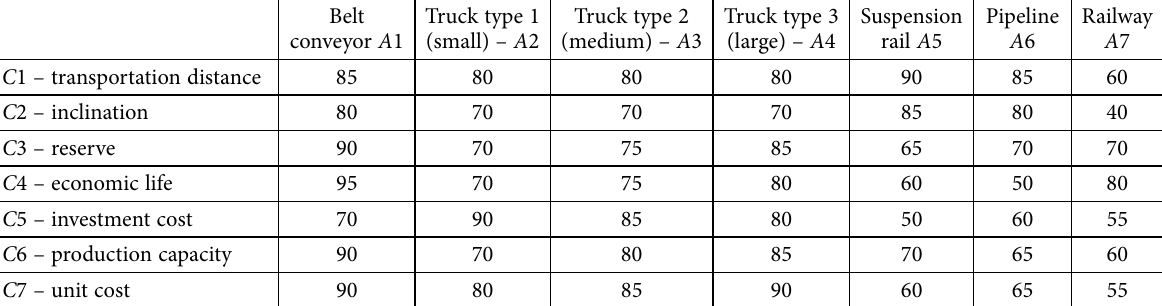
Table 3. Performance scores of alternative transportation modes according to each decision